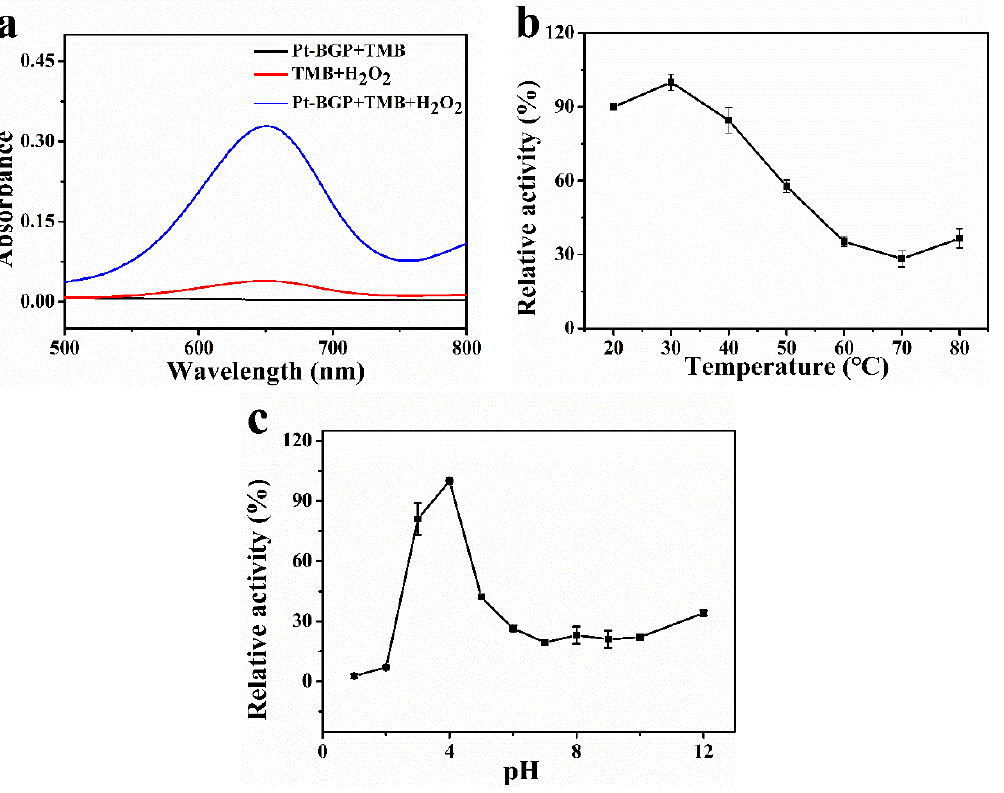
Figure 4. ( a ) UV-Vis spectra of different sample solutions; effect of ( b ) temperature and ( c ) pH on the catalytic activity of Pt-BGP NCs.